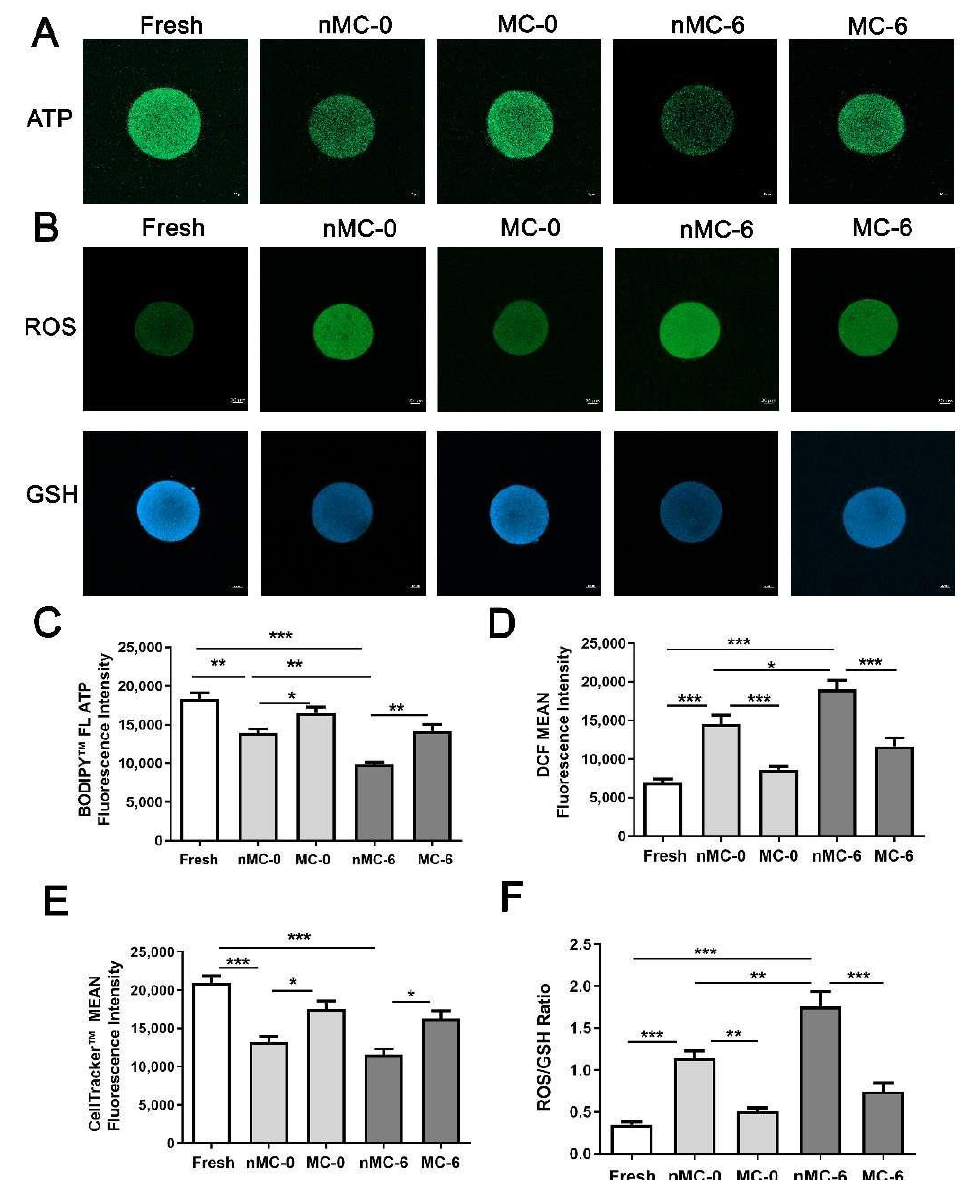
Figure 6. Effect of prolonged cryopreservation and 10 -9 M MT treatment on mitochondrial function in cryopreserved human oocytes from the nMC-0 group, MC-0 group, nMC-6 group and MC-6 group. Fresh oocytes (F group) served as the control. ( A )ATP levels in cryopreserved human oocytes. BODIPY TM FL ATP staining was performed to measure the intracellular ATP levels, and the staining was detected using confocal microscopy. Bar = 20 µ m. ( B ) ROS and GSH level in cryopreserved human oocytes. DCHFDA staining was performed to measure the intracellular ROS levels, CellTracker TM staining was performed to measure the intracellular GSH levels, and the staining was detected using confocal microscopy. Bar = 20 µ m. ( C ) BODIPY TM FL ATP fluorescence intensity was quantified. Data were expressed as the mean ± SEM. * p < 0.05, ** p < 0.01 and *** p < 0.001. ( D ) DCHFDA fluorescence intensity was quantified. Data were expressed as the mean ± SEM. * p < 0.05 and *** p < 0.001. ( E ) CellTracker TM fluorescence intensity was quantified. Data were expressed as the mean ± SEM. * p < 0.05 and *** p < 0.001. ( F ) Ratio of ROS/GSH in long-term cryopreserved human oocytes. The fresh group served as control. Data were expressed as the mean ± SEM. ** p < 0.01 and *** p <